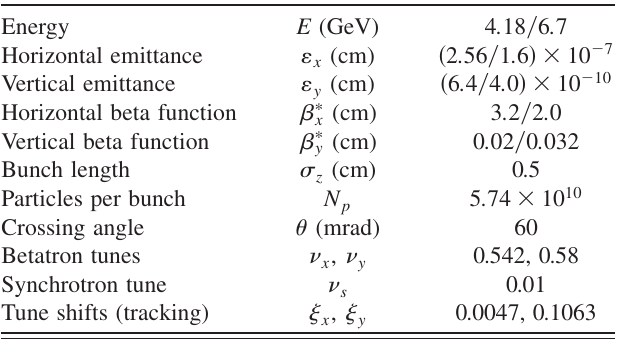
TABLE II. The main SuperB parameters (LER/HER), as of September